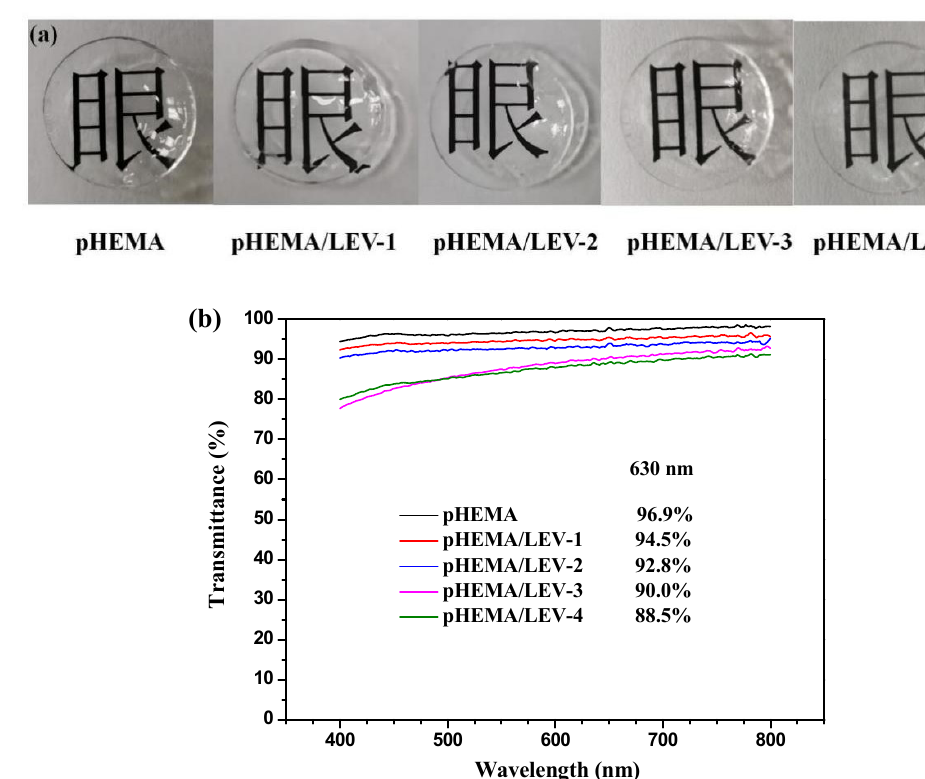
Figure 6. Photographs ( a ) and transmittance spectra ( b ) for the series of nanogel-embedded contact lenses.